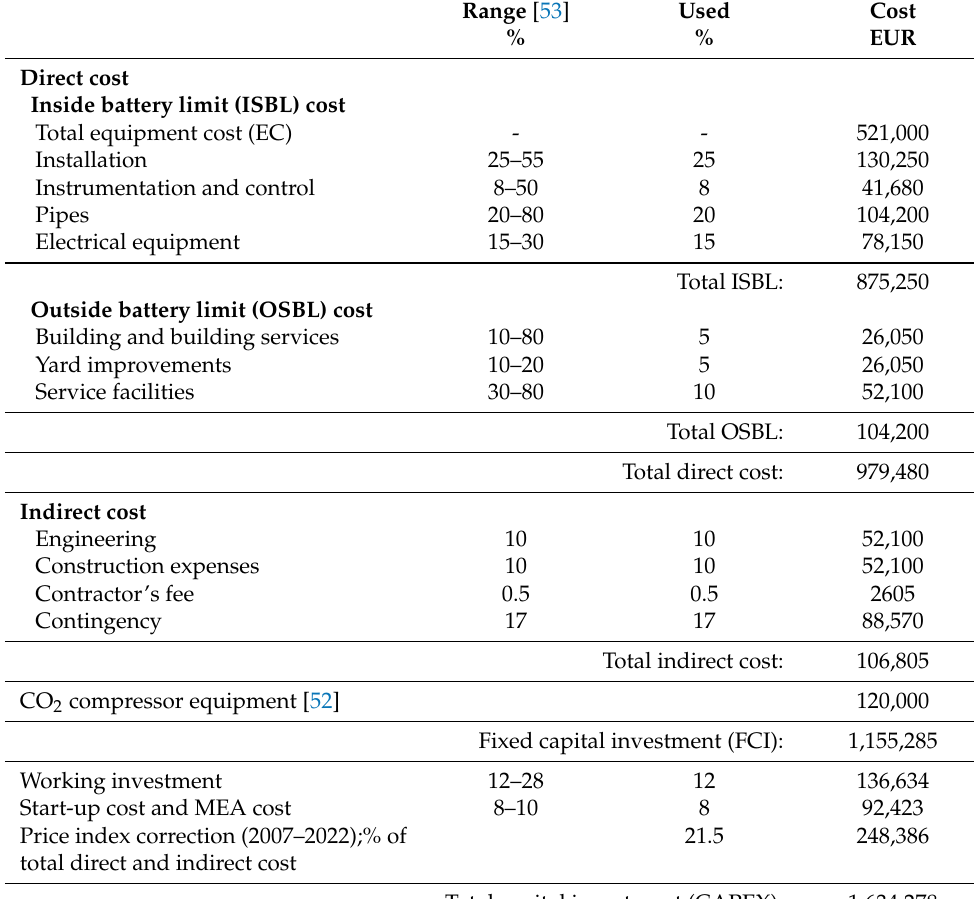
Table 8. Total capital investment (CAPEX) for MEA CO 2 separation